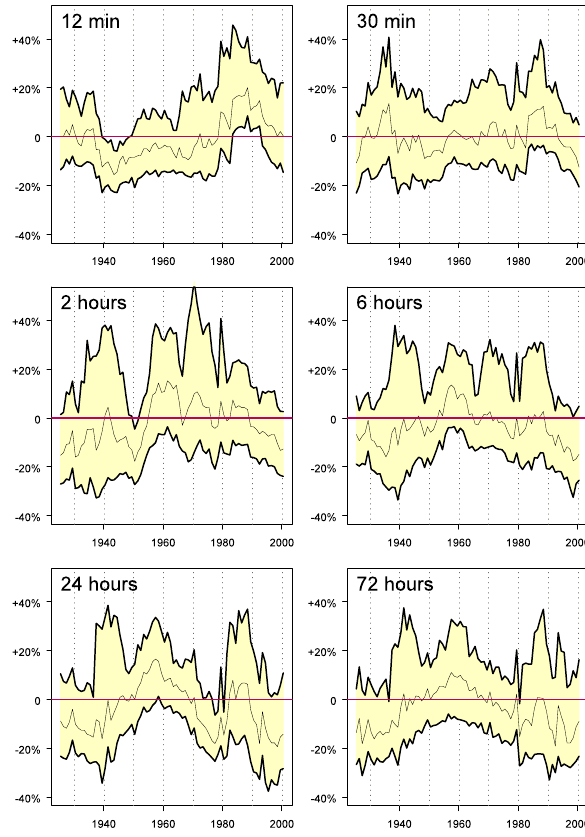
Fig. 4. Average deviation in quantile estimates for 10-yr slid- ing windows against long-term average for 6 durations based on POT20. Quantile estimates are derived empirically. Deviations are based on an average between the 50th and 90th percentile.